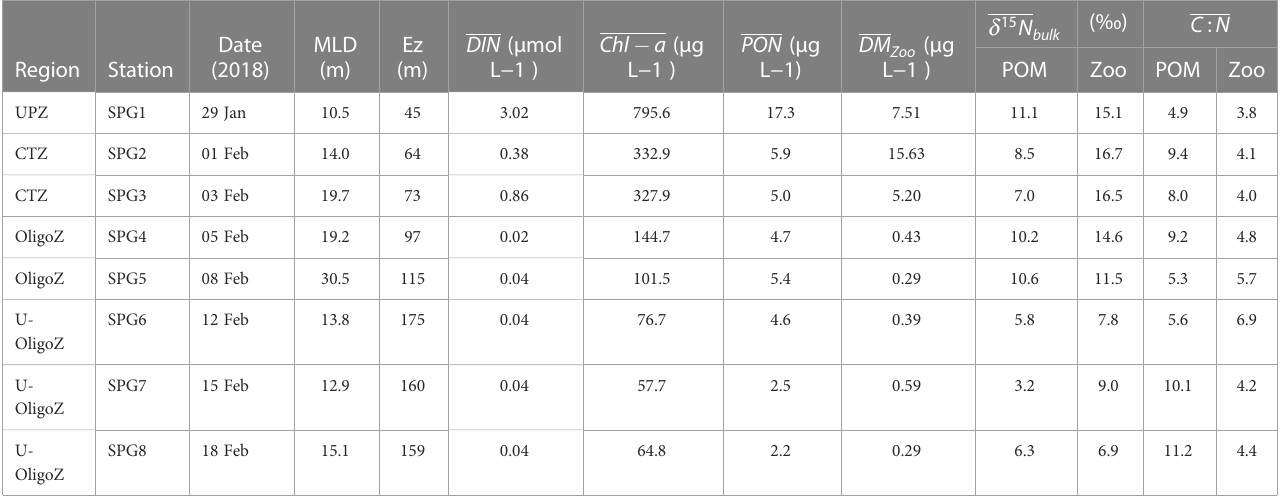
TABLE 1 Environmental characteristics of those stations sampled during the EPIC cruise.